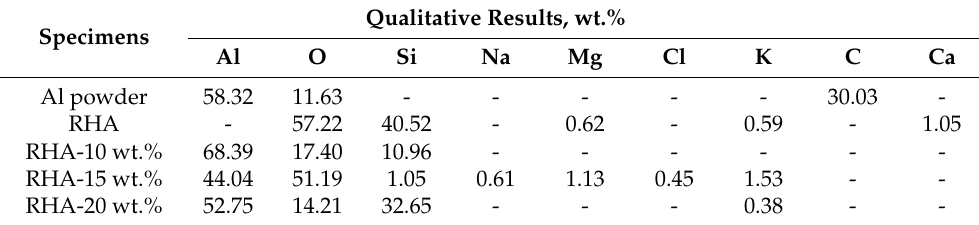
RHA-10 wt.% RHA-15 wt.% RHA-20